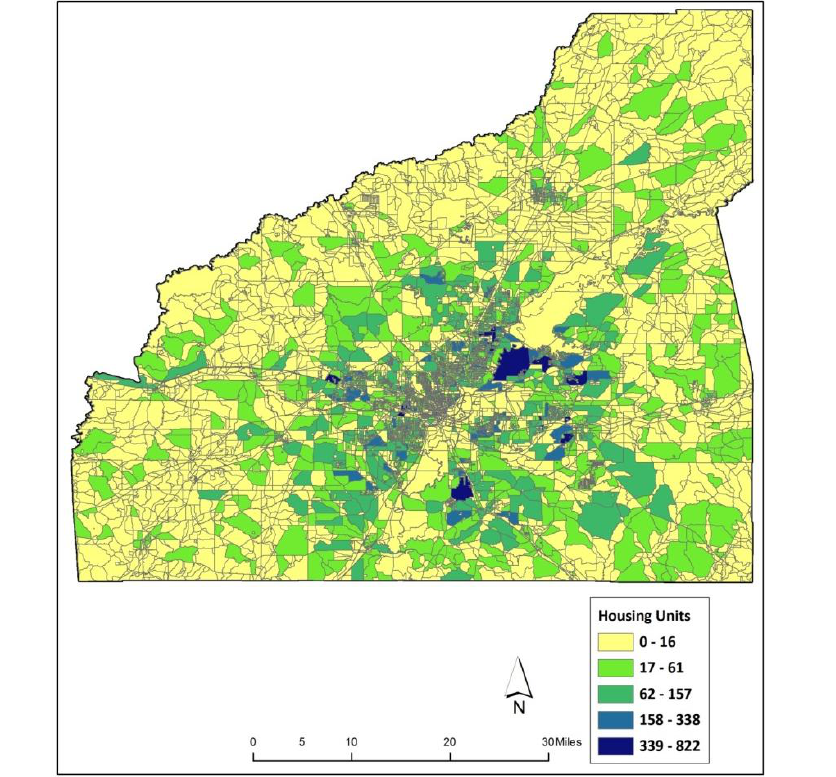
Figure 7. Housing Units at block level in Hinds, Rankin and Madison County, MS.